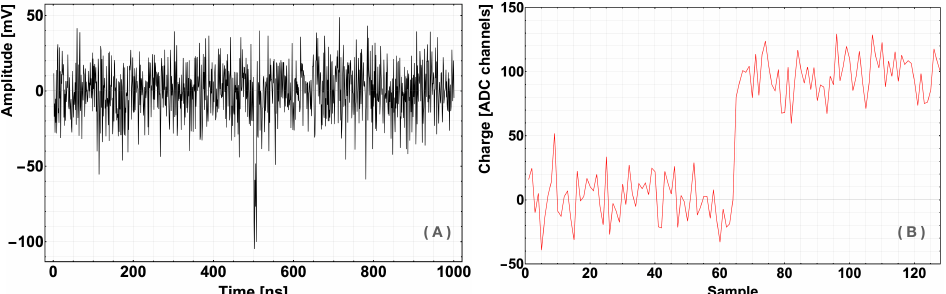
Figure 10. ( A ) A typical PMT signal triggered by a gamma-ray interaction in the target. ( B ) The cor- responding charge signal (in ADC channel units) sampled by the ADC.